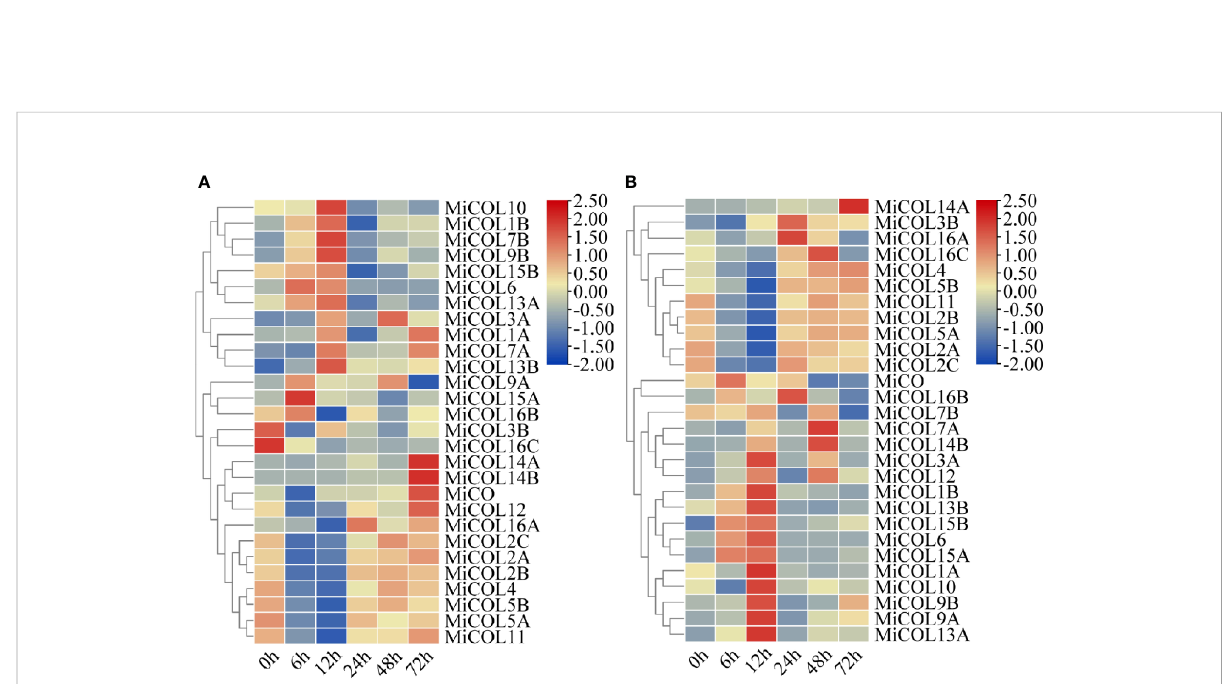
FIGURE 6 Expression patterns of MiCOL genes after different stress treatments. (A) Under 300 mM NaCl. (B) Under 30% PEG 6000 for drought simulation. The color gradient (red/yellow/blue) indicates the gene expression level (from high to